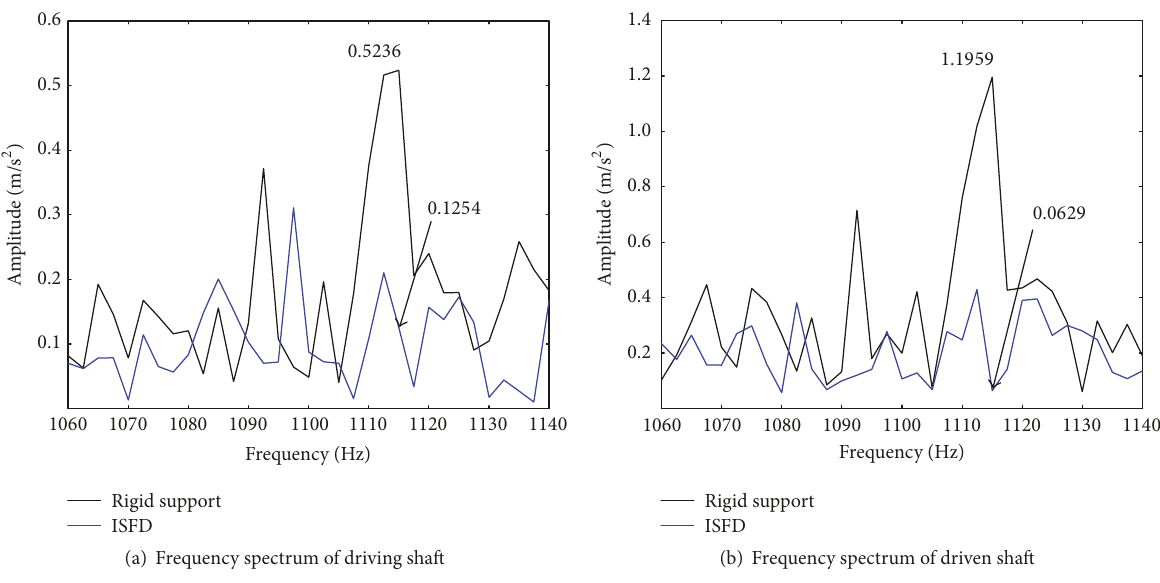
Figure 12: Comparison of data in the range of 560 ∼ 640 Hz.